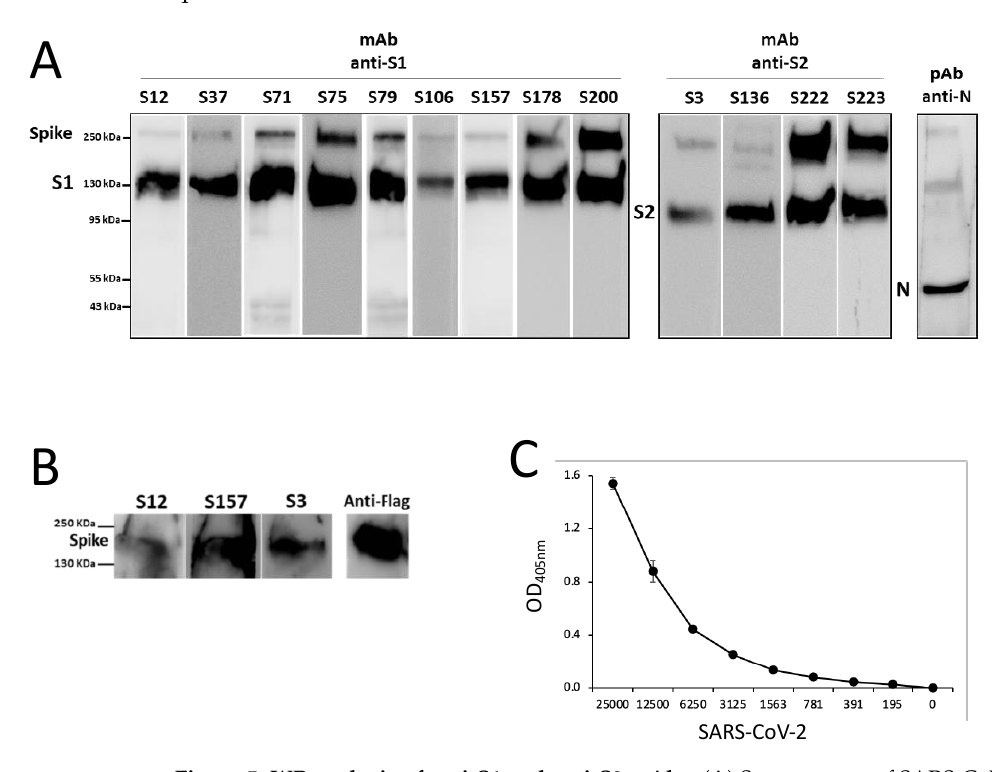
Figure 5. WB analysis of anti-S1 and anti-S2 mAbs. ( A ) Supernatants of SARS-CoV-2-infected Vero E6 cells subjected to SDS-PAGE and WB. Polyclonal antibody against SARS-CoV N protein was used as a positive control. One experiment representative of three is shown. ( B ) WB analysis of anti-S1 mAbs (S12 and S157), anti-S2 mAb (S3), and anti-Flag, the latter as a control of transfection; SDS-PAGE of cell lysates from HEK293T-expressing SARS-CoV spike protein followed by WB is shown. One experiment representative of three is shown. ( C ) Sandwich ELISA with S71 – S79 pair of mAbs for the detection of scalar quantities of SARS-CoV-2 (PFU/well). Error bars indicate the standard deviations of technical duplicates from a representative experiment repeated twice.